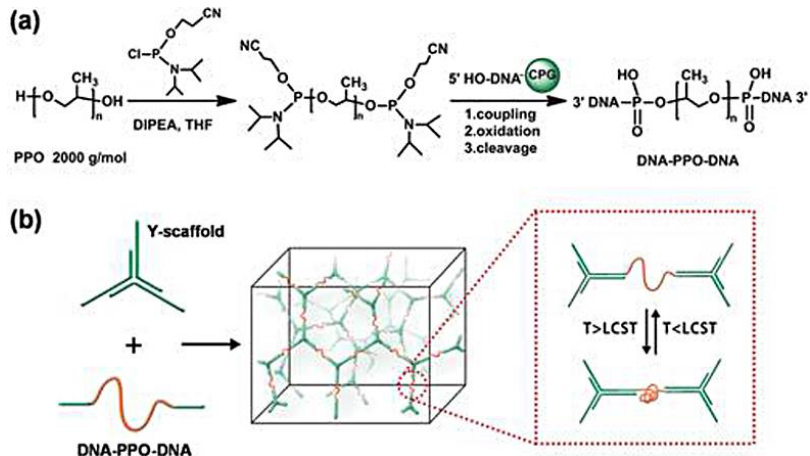
Figure 6. Illustration of the intramolecular collapse of PPO in a 3D DNA network. The solid phase synthesis of ssDNA- b -PPO- b -ssDNA ( a ) and the formation process of a 3D DNA network ( b ). The green color stands for DNA strands and the red color indicates PPO. Reproduced with permission from